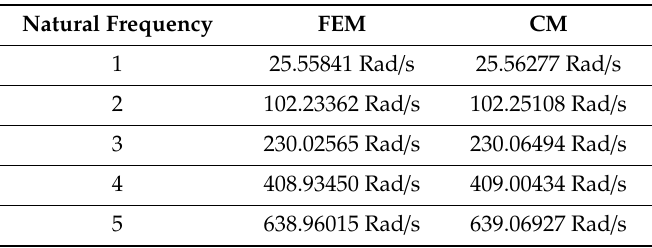
Table 1. Comparison of natural modes for a bare beam. FEM: finite element method; CM: classical numerical